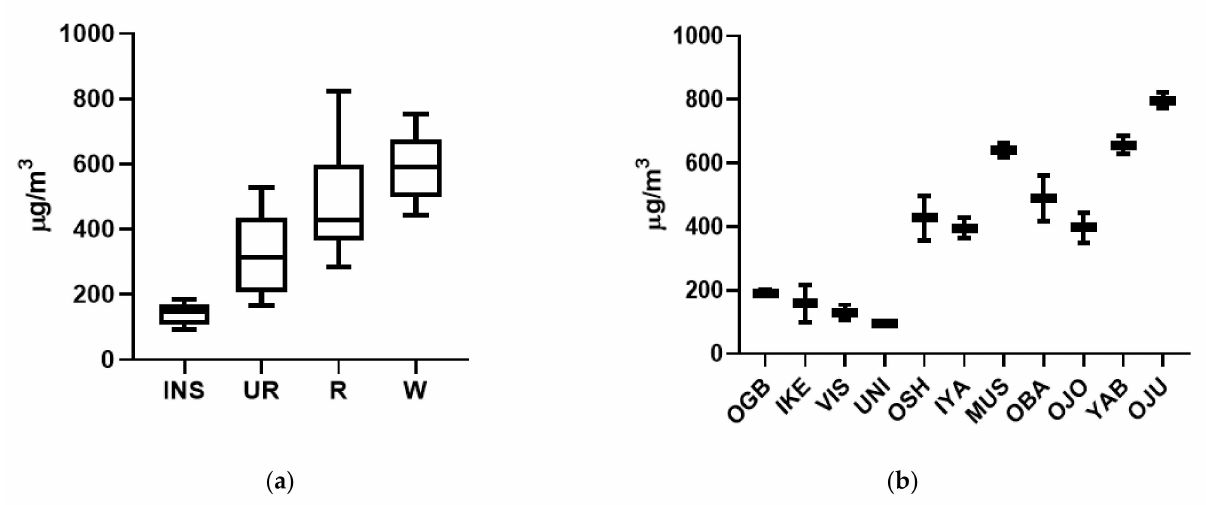
Figure 2. Concentration of TVOCs measured at individual sites in ( a ) Nairobi and ( b ) Lagos. Location name key can be found in Table